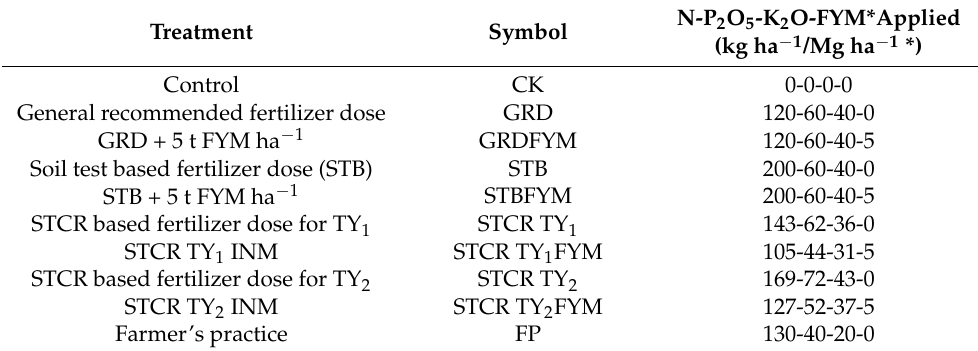
Table 1. Treatment details of the verification experiment. Treatment Symbol Control CK 0-0-0-0 General recommended fertilizer dose GRD Soil test based fertilizer dose (STB) STCR based fertilizer dose for TY